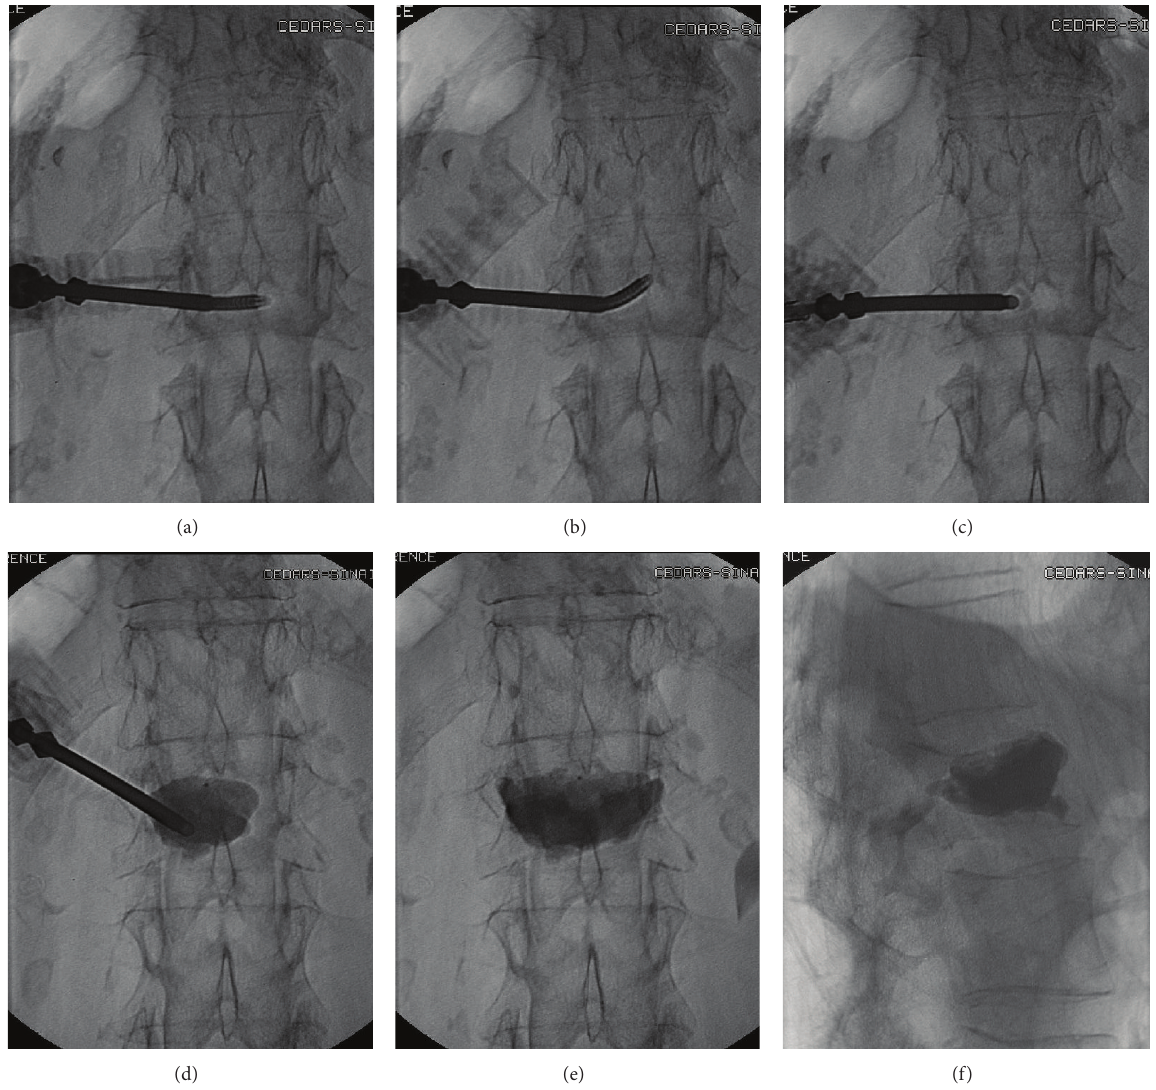
Figure 2: Stepwise unipedicular RF-TVA procedure including (a) controlled intravertebral cavity creation with MidLine Osteotome articulated across vertebral midline, (b) osteotome reinserted cranially to create additional site-specific cavities, (c, d) targeted delivery of StabiliT ER2 ultrahigh viscosity PMMA, and (e) anteroposterior and (f) lateral views demonstrating extensive PMMA trabecular interdigitation and controlled vertebral height